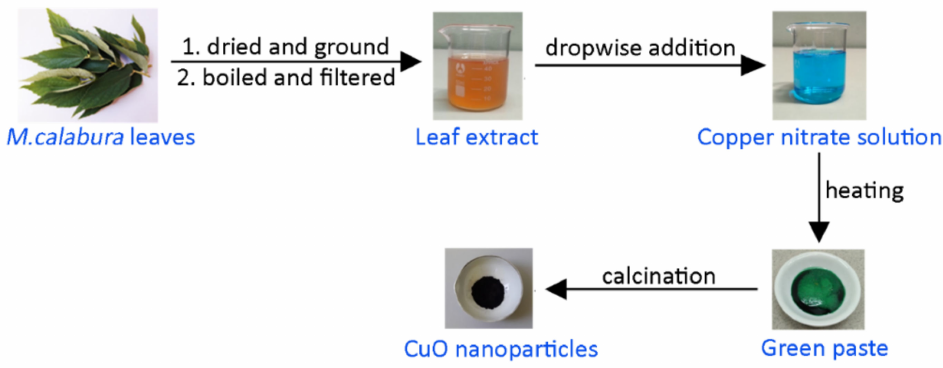
Figure 1. Experimental procedure for green synthesis of CuO